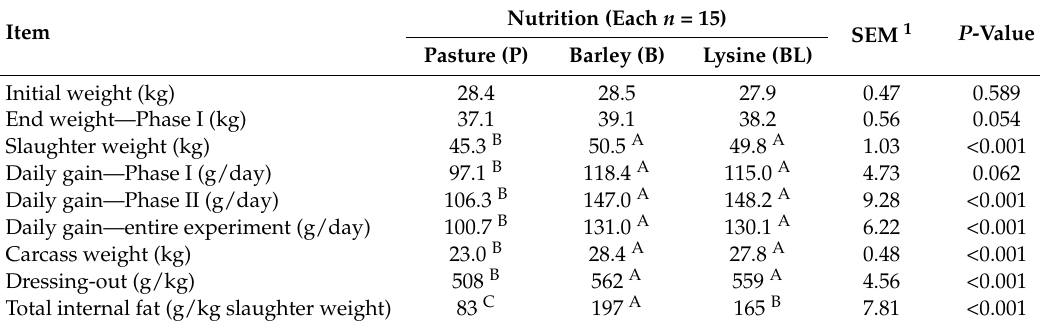
Table 2. Growth performance and slaughter traits of fallow deer bucks ( n =